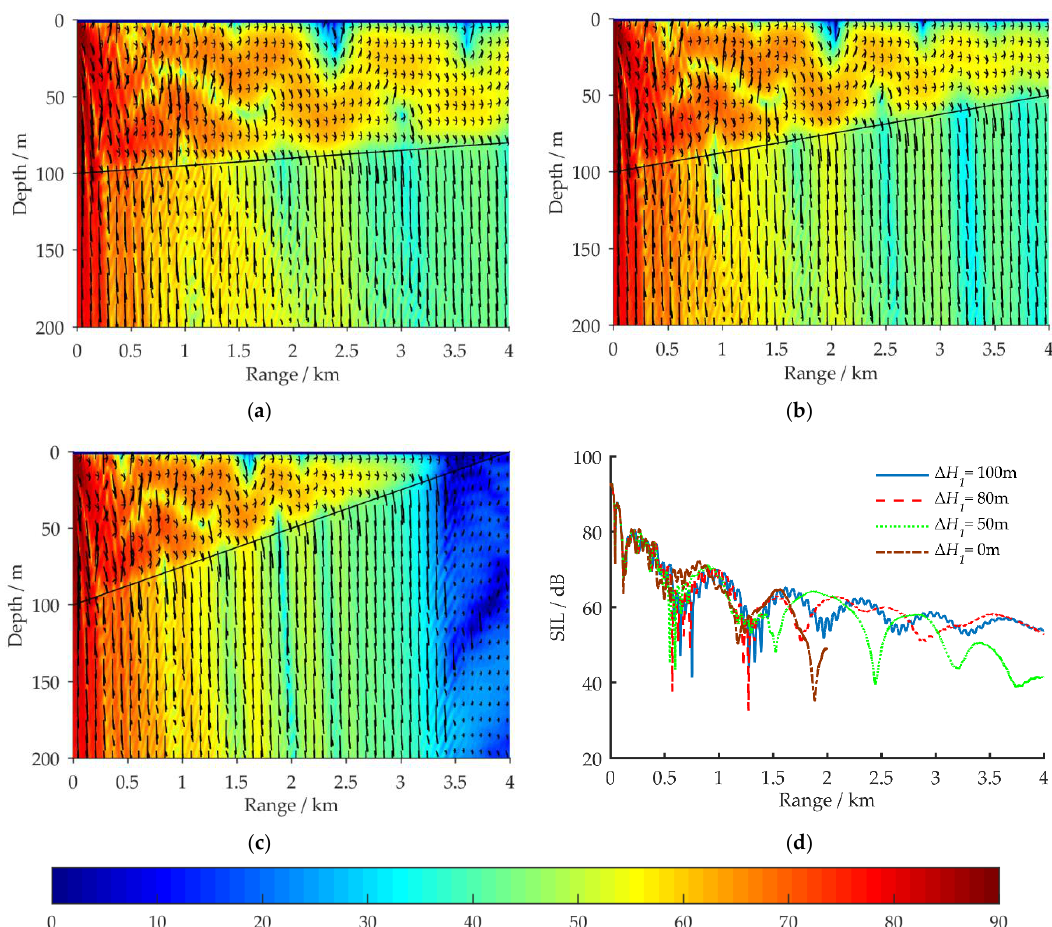
Figure 5. Distribution of the 100 Hz acoustic energy flux (SIL) in a full waveguide of shallow water with wedge-shaped uphill sea bottoms; aside from △ H 1 , the environmental parameters are the same as in Figure 2a: ( a ) △ H 1 = 80 m; ( b ) △ H 1 = 50 m; ( c ) △ H 1 = 0 m; ( d ) comparison results of SIL curves for four simulation conditions: △ H 1 = 100, 80, 50, and 0 m, with a receiving depth of z = 50 m.